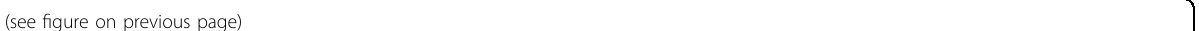
Fig. 4 Gene regulatory network of aortic SMCs and inter-lineage communication analysis of the aortic tissues at the early stage of TAAD. a Comparative analysis of the gene regulatory networks of SMCs between BAPN (left panel) and CTRL (right panel) reveals dysregulated genes in the early stage of TAAD (7 days after BAPN administration). The node size re fl ects degree centrality. The top 28 genes ranked by delta degree are colored in red. b The average expression of the top dysregulated genes in SMCs of BAPN and CTRL. c Cell – cell communication networks in the aortic tissues of BAPN (left panel) and CTRL (right panel). The node size re fl ects the total number of communications for each lineage. The edge color indicates that the ligands are broadcast by the cell lineage in the same color. The line thickness is proportional to the number of broadcast ligands. d The ligand – receptor pairs with signi fi cant changes in speci fi city between any one of the non-SMC lineages and SMCs in BAPN vs CTRL at the early stage of TAAD. SMCs express receptors and receive ligand signals from other lineages. e The representative ligand – receptor pairs with signi fi cant changes in speci fi city between SMCs and the other lineages in BAPN vs CTRL at the early stage of TAAD. SMCs express ligands and broadcast ligand signals for other lineages. In d and e , the dot size re fl ects the P value of the permutation tests for lineage-speci fi city, and the dot color denotes the mean of the average ligand – receptor expression in the interacting lineages. CTRL, control; EDO, endothelial cell; FB, fi broblast; MAC, macrophage; SMC, smooth muscle cell; TC, T cell; B cells are not considered due to too few